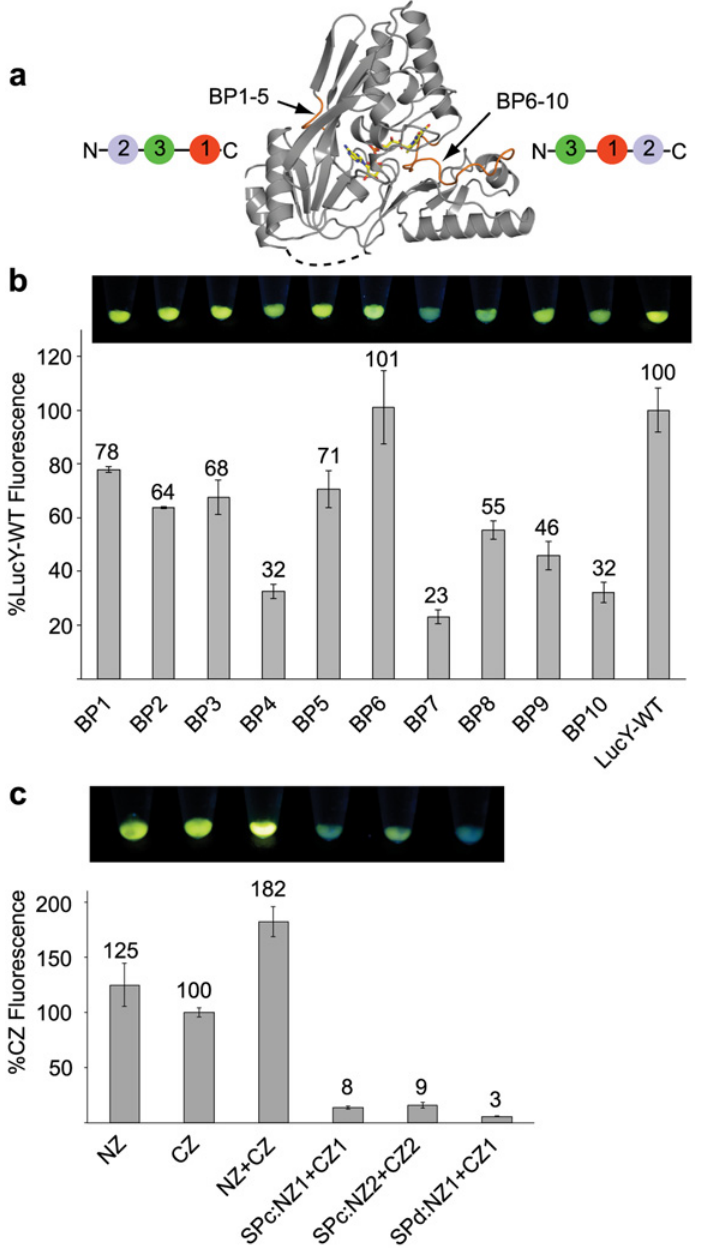
Fig 6. Circular permutation of LucY. (a) Domains 1 and 3 were connected with a small linker (dashed line), and new N and C-termini were created by making Break Points (BP) between domains 1 and 2 (BPs1-5) or between domains 2 and 3 (BPs6-10). (b) Fluorescence of circularly permutated LucY molecules was compared to wild type. (c) Split points were made from a circular permuted LucY such that domains 3 and 1 make up one half and domain 2 makes up the other. Fluorescence of the co-expressed pair is represented as a percentage of CZ. Image above each graph shows whole cell pellets of corresponding sample under UV light. Error bars represent standard deviation from the mean (n =